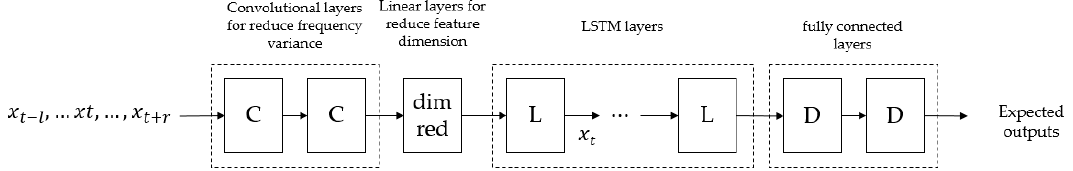
Figure 2. Structure of CLDNN model.